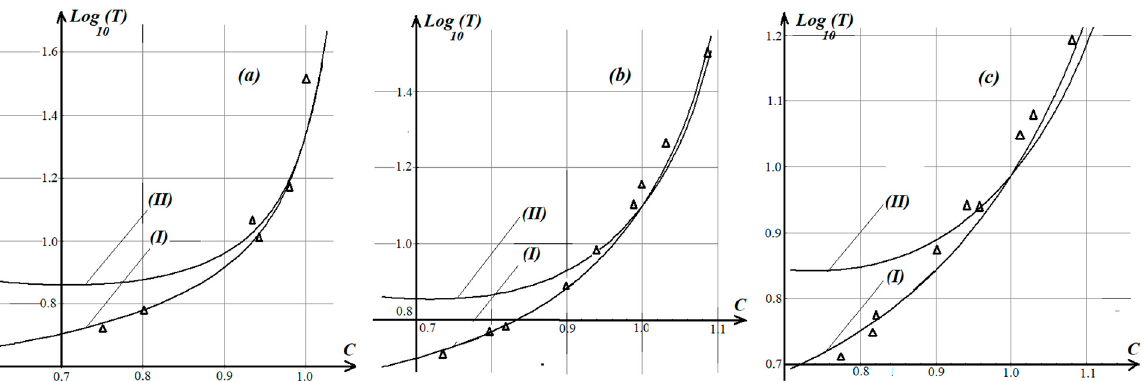
Figure 3. Dependence of the period T on the wave phase velocity C for different wave heights H: ( a ) H = 0.1, ( b ) H = 0.3 and ( c ) H = 0.5; (I) FN model , (II) BM model ; triangles—experimental data [6].